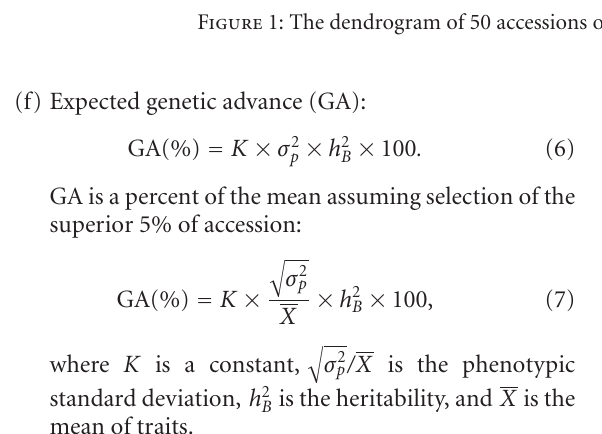
Coefficient0.95 2.28